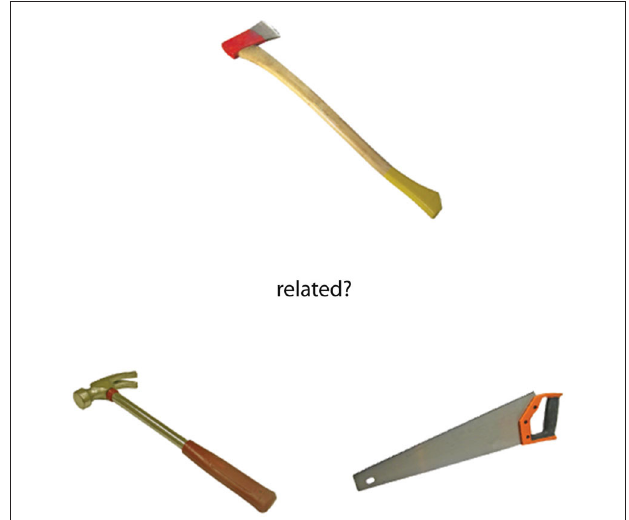
FIGURE 1 | Example of an encoding trial, presented for 7 s . Encoding instructions could be either “Related?” or “Smaller?”. The object triad was preceded by the task instruction for 2 s (to serve as a warning that the triad would soon appear), and followed a variable ISI from 1000 to 5000 ms (mean 3000 ms). Trials were identical during the recognition block except the instruction as always